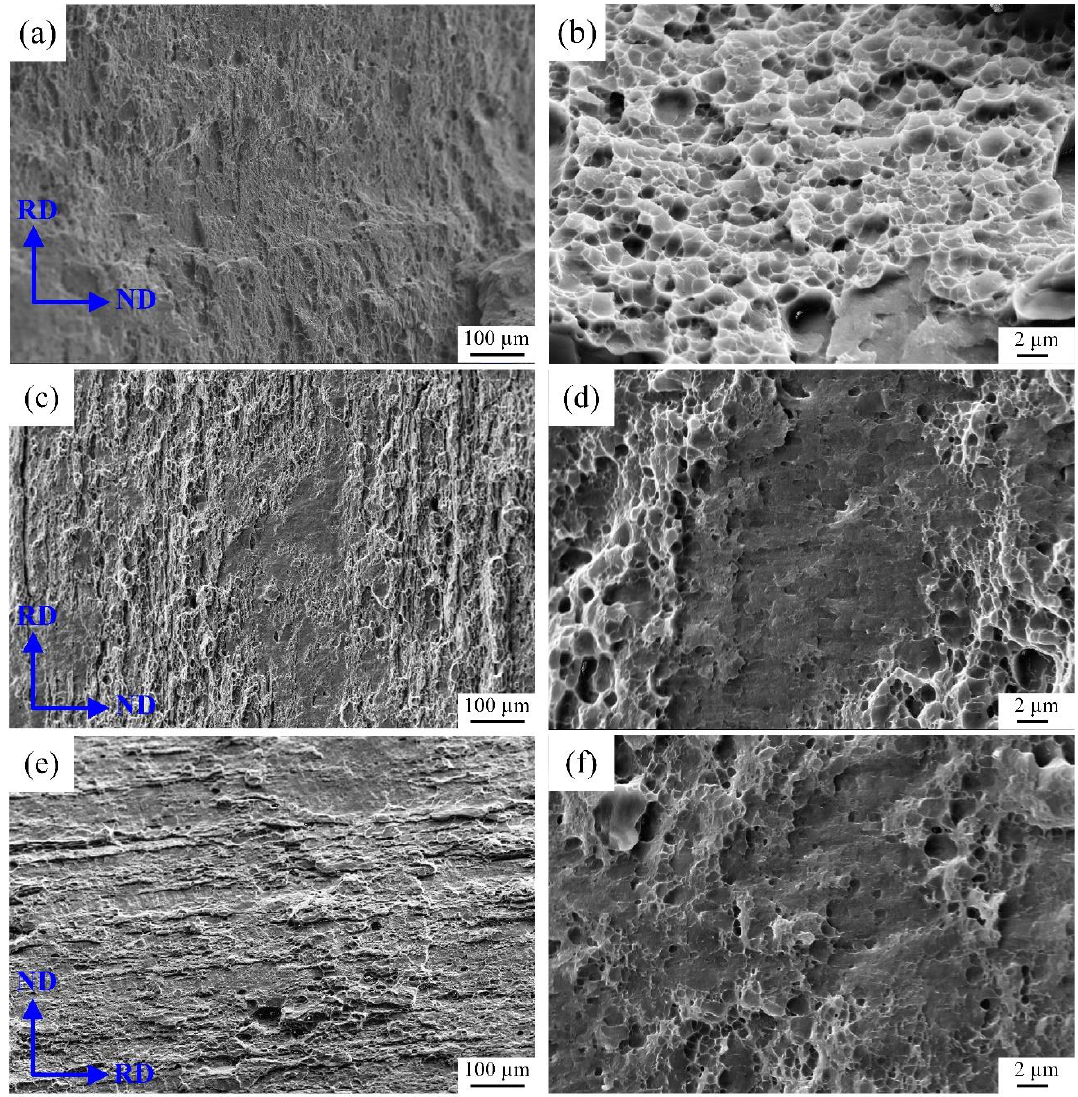
Figure 5. The fracture morphology and corresponding magnified images of 7N01 aluminum alloy ( a , b ) base metal; ( c , d ) 300 °C and ( e , f ) 350 °C.